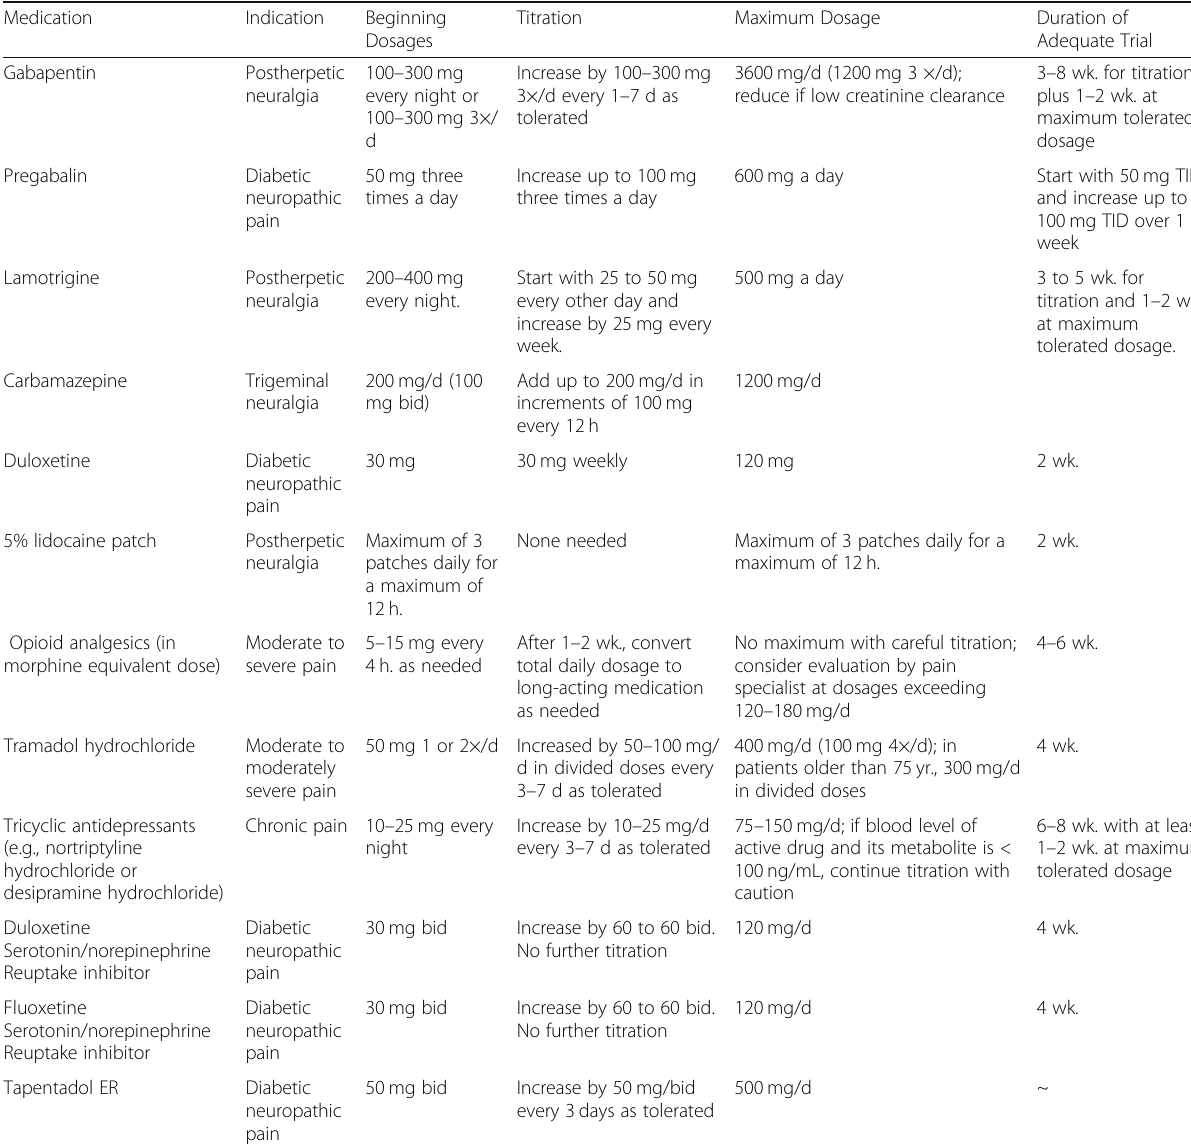
Table 2 FDA approved neuropathic pain